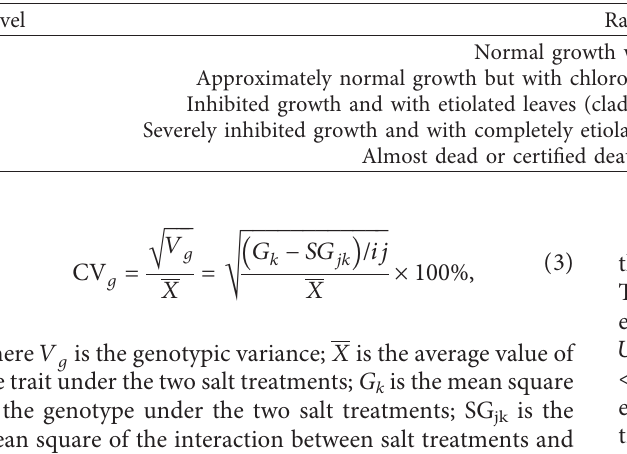
Table 3: The ranking criteria of seedlings after salt